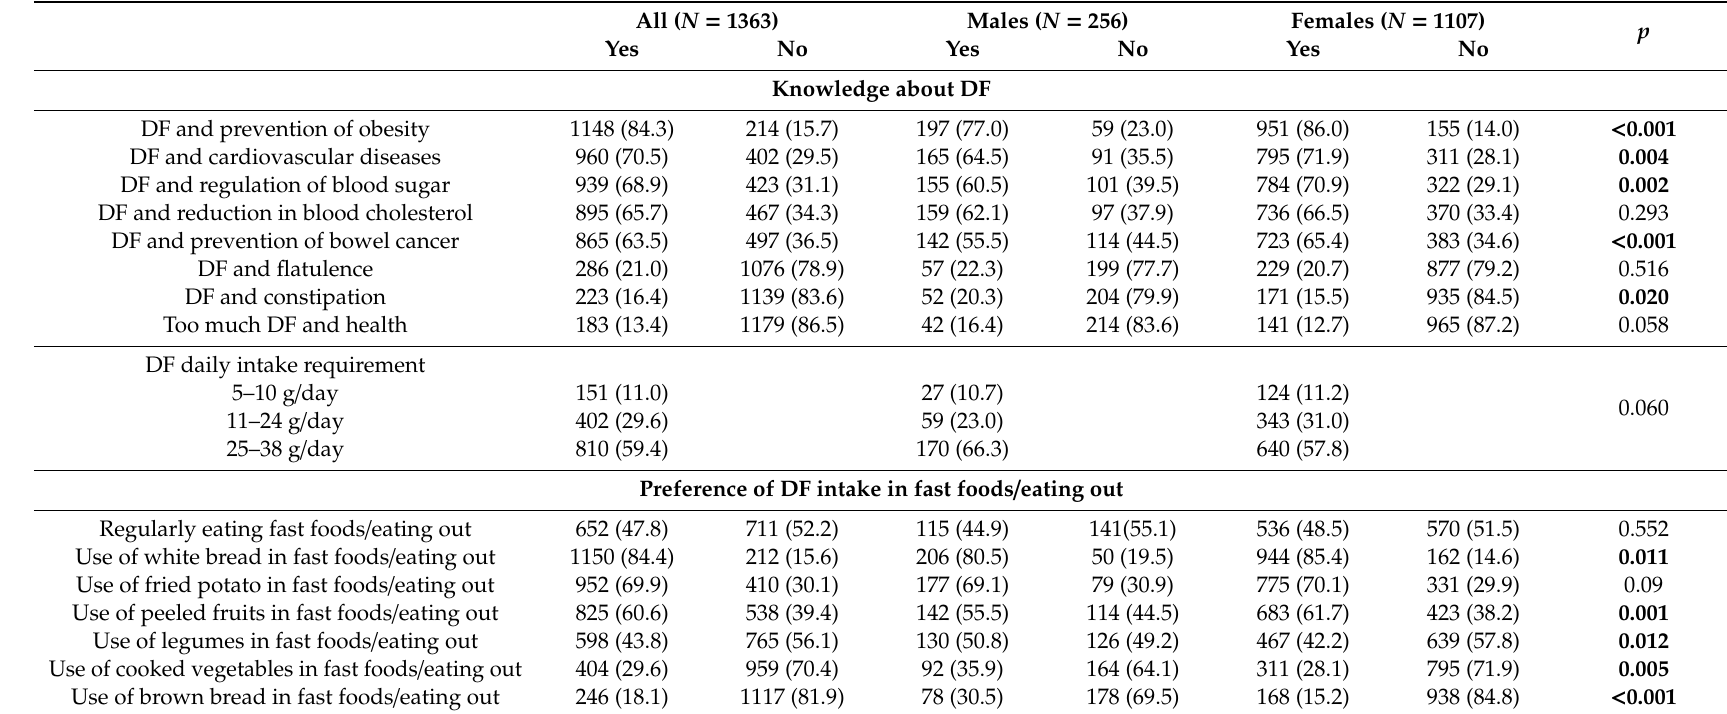
Table 3. Knowledge about dietary fibers in study